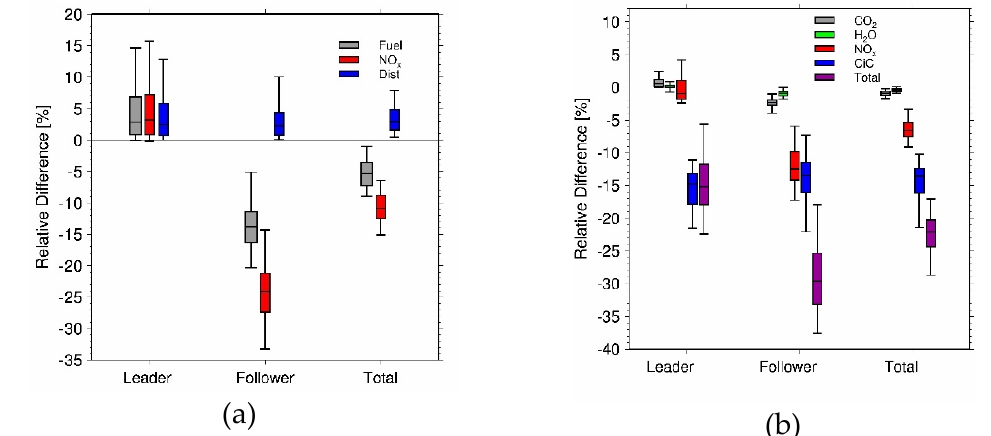
Figure 3. ( a ) Relative change in fuel consumption, NO x emissions and flown distances for leader, follower and the total formation for the Top50 scenario compared to the reference case where both aircraft fly not in formation. ( b ) Change in total climate impact and climate impact of the different species relative to the change in total climate impact. The bars indicate the 25% and 50% percentile and the whiskers indicate the 95% confidence interval of the different formations in one data set.